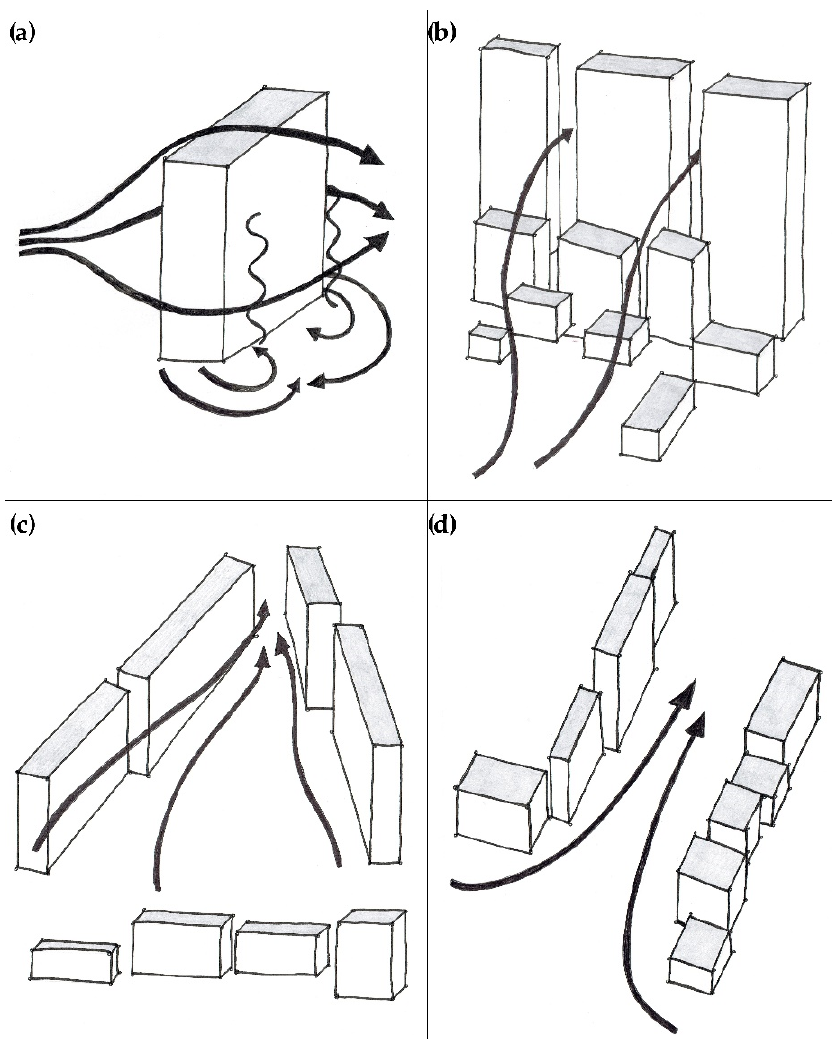
Figure 2. Disturbed wind flow in urban areas: ( a ) formation of vortices, ( b ) wind protection effect, ( c ) Venturi effect, ( d ) channeling.